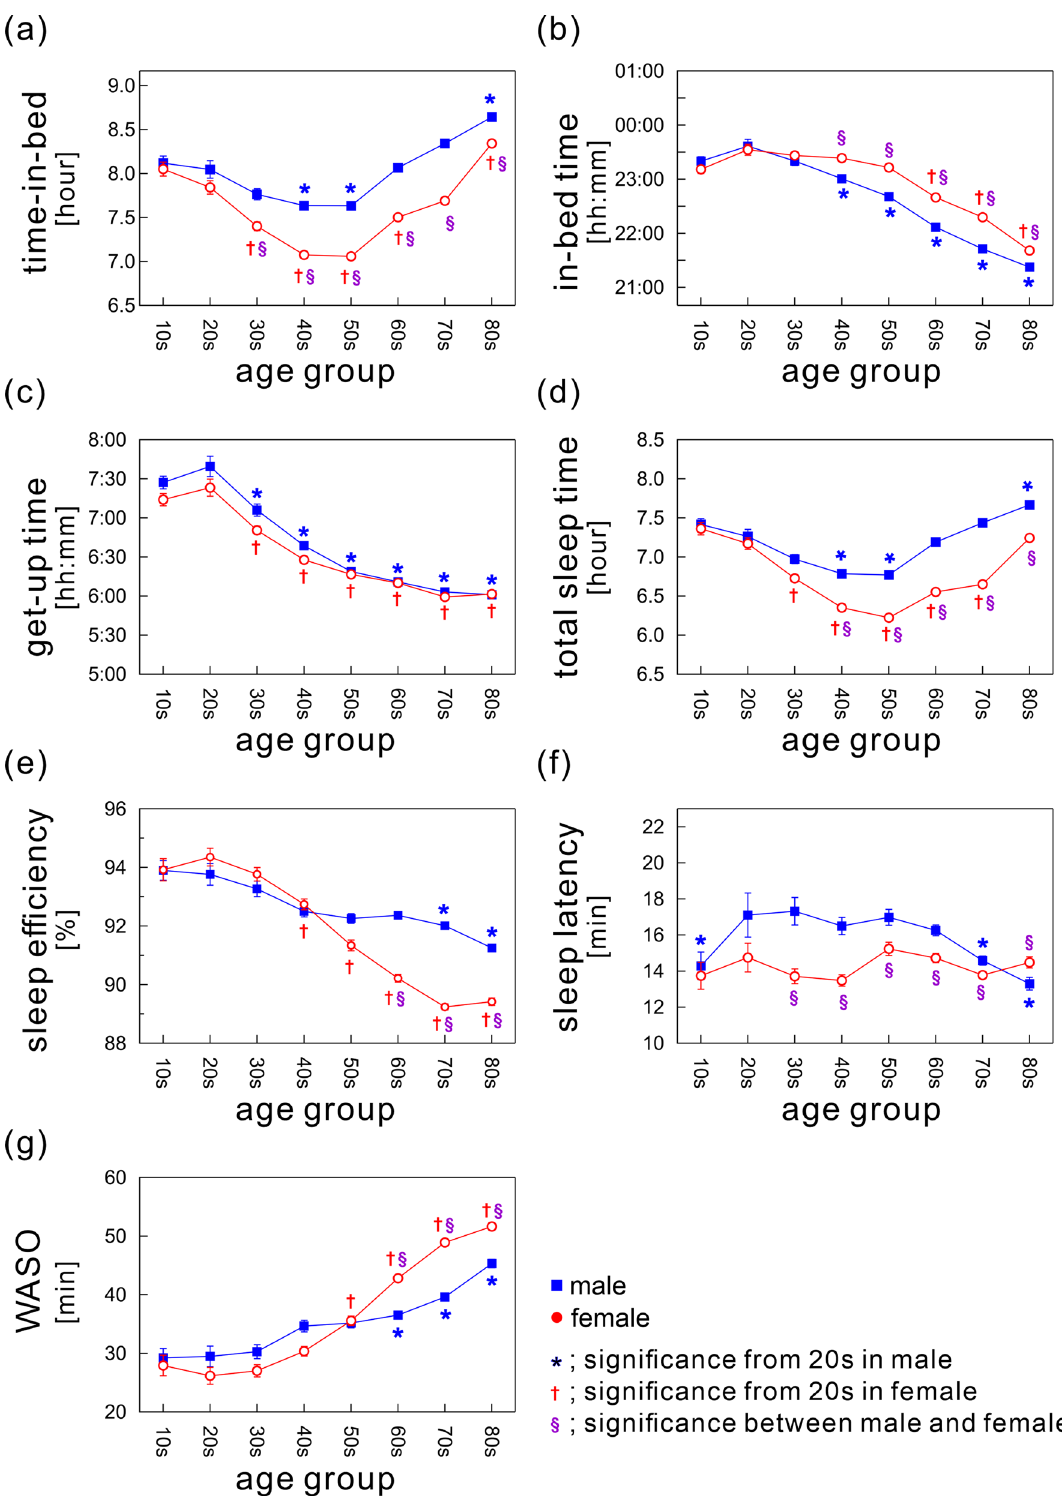
Figure 3. Gender differences in sleep parameters: ( a ) time-in-bed (TIB), ( b ) in-bed time, ( c ) get-up time, ( d ) total sleep time, ( e ) sleep efficiency, ( f ) sleep latency, and ( g ) wake time after sleep onset (WASO). The mean values of each sleep parameter for each gender are shown as a function of age, ranging from age 10 to 89 years divided into eight age groups with 10-year intervals (men, blue rectangles; women, open red circles). The error bars indicate the standard error of the mean. * and † Indicate significant age-dependent changes in males and females, respectively, compared with the 20s age group ( p < 0.01). § Indicates significant gender differences ( p <